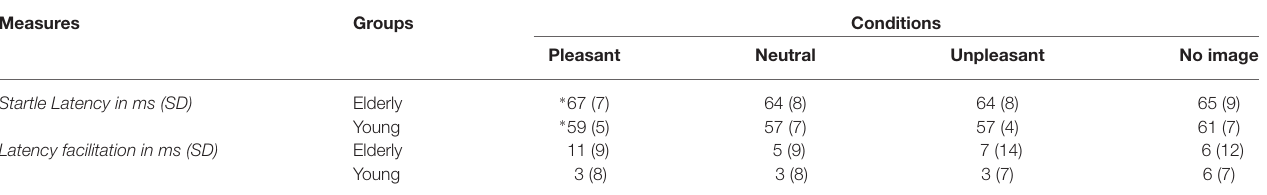
TABLE 2 | Latency of the startle reflex and latency facilitation of the prepulse inhibition values (in ms) for all emotional conditions for both groups. Measures